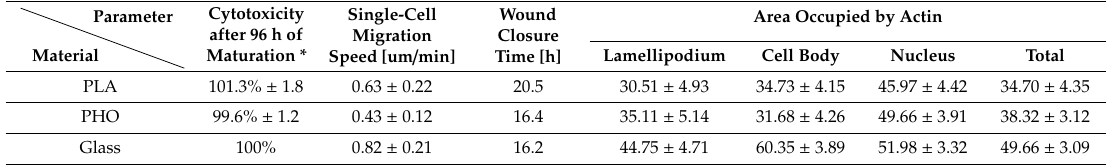
Table 1. Summary of obtained results for MEF 3T3 cells studied on two